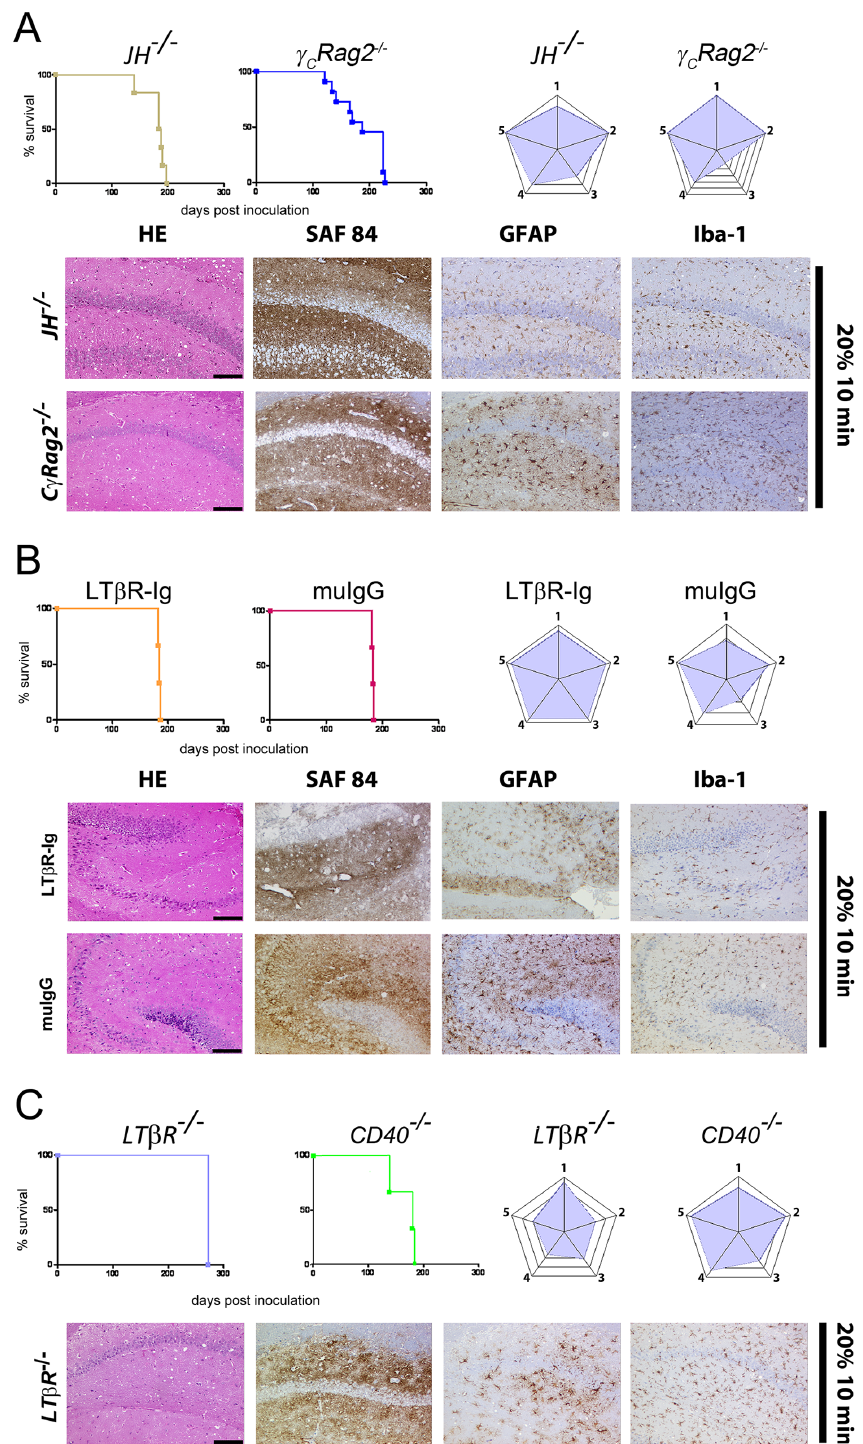
Fig 3. Prion transmission through aerosols in immunocompromised mice. Survival curves, lesion severity score analysis (radar plots), and representative histopathological micrographs of mice with genetically or pharmacologically impaired components of the immune system ( JH − / − , γ C Rag2 − / − ) (A), 129Sv mice treated with LT β R-Ig or with muIgG (B), LT β R − / − and CD40 − / − mice (C). All mice were exposed for 10 min to aerosolized 20% IBH. Stain code: HE (spongiosis, gliosis, neuronal cell loss), SAF84 (PrP Sc deposits), GFAP (astrogliosis) and Iba-1 (microglial activation) as in Fig 1H. Scale bars: 100 μ